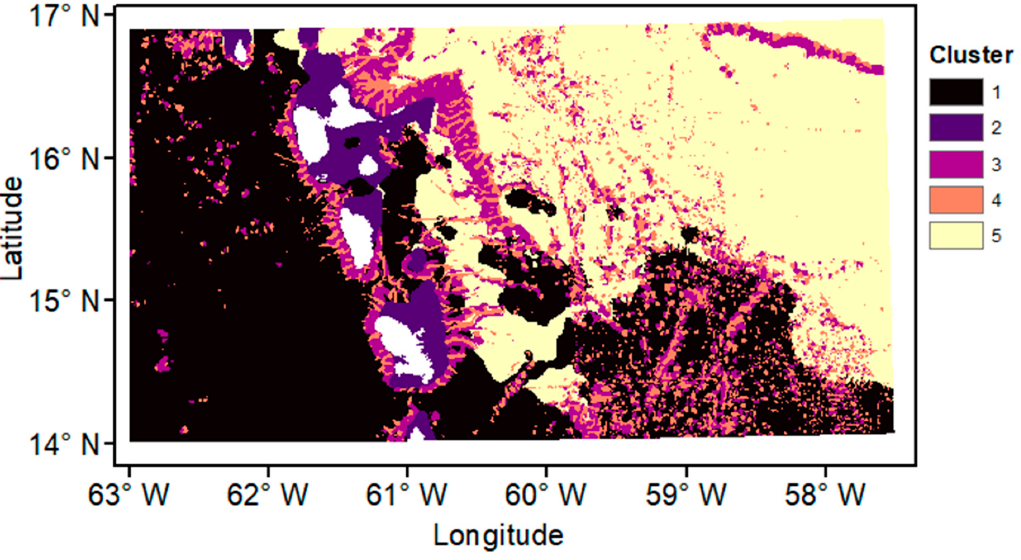
Figure 5. Broadscale Landscape Map for the smaller study area, using three eigenvalues. Showing the K-means cluster analysis results of the four cluster